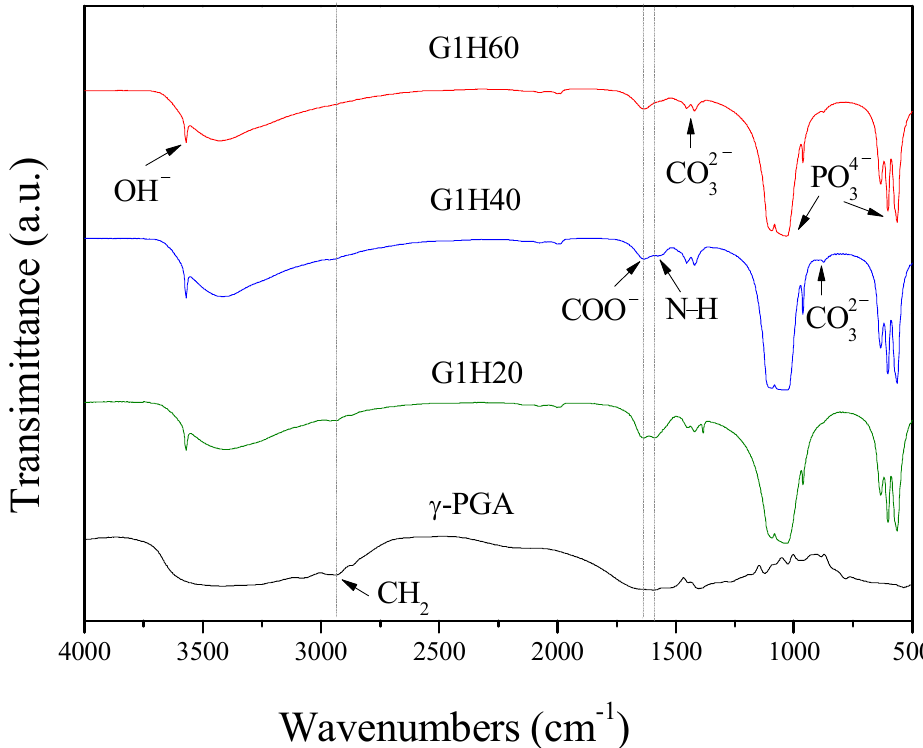
Figure 1. FTIR absorption spectra of poly-γ-glutamate (γ-PGA) and poly-γ-glutamate/apatite (PGA-AP) nanoparticles.